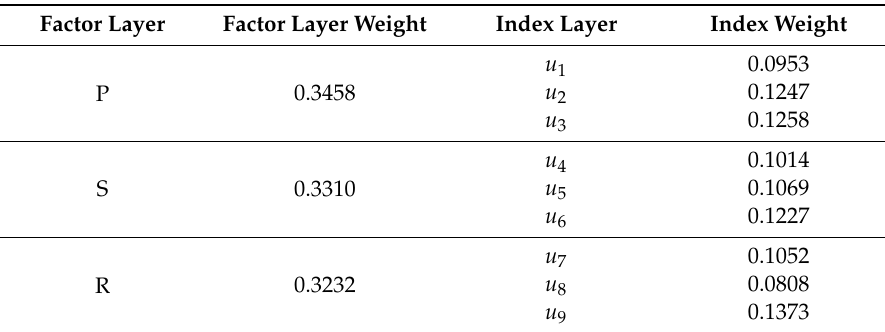
Table 2. Index weight of each influencing factor.